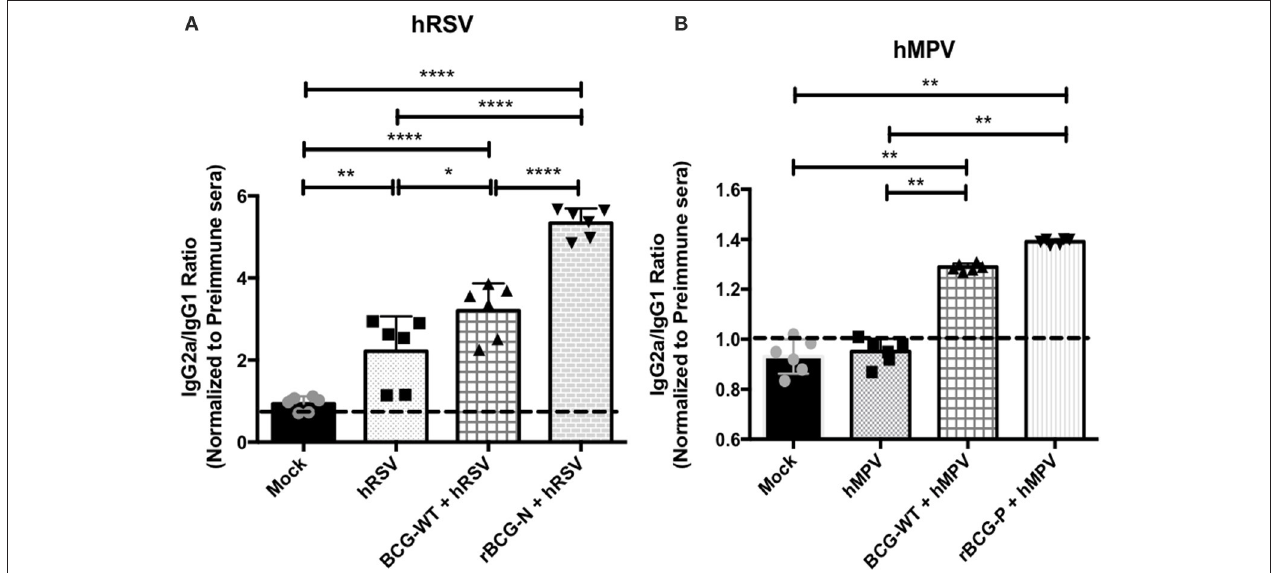
FIGURE 4 | The rBCG strains induce a strong IgG2a isotype switching after a viral infection. The secretion of specific antibody isotype IgG2a and IgG1 was measured in both vaccines by indirect ELISA. The assay was done using a total virus extract and expressed as the ratio between the IgG2a and IgG1 in animals infected with hRSV (A) and hMPV (B) . Secretion of this specific antibody was measured from sera at 14 dpi (hRSV) or 49 dpi (hMPV) using total extract of each virus to incubate the plate. The bars observed in the (A) are accordingly: Mock-treated, hRSV-infected, BCG-WT + hRSV, and rBCG-N + hRSV. On the other hand, the bars observed in (B) are accordingly: Mock-treated, hMPV-infected, BCG-WT + hMPV, and rBCG-P + hMPV. The measure was made at 450nm. The sera from six different animals for each group was used for the ELISA assay, with each serum tested in three replicates. N = 3 for each group, with two independent experiment. Differences among groups were evaluated by a one-way ANOVA (* p ≤ 0.05; ** p ≤ 0.01; *** p ≤ 0.001; **** p ≤ 0.0001). The error bars represent the Standard Deviation